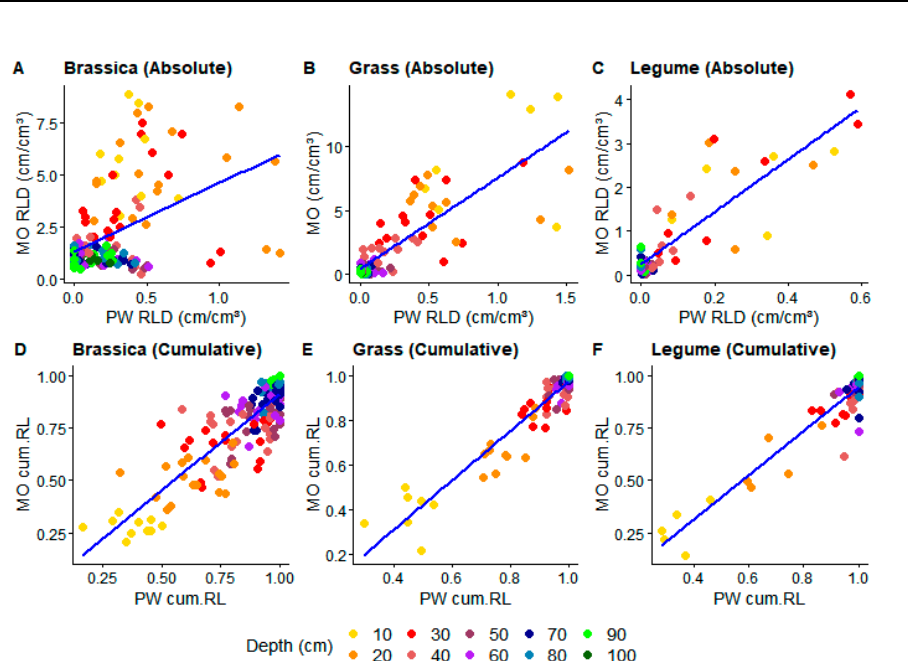
Figure 1. Linear regression fitting between monolith and profile wall root ‐ length density (RLD) in training data for absolute ( A – C ) and cumulative (cum.RL) data ( D – F ). Colors show soil depth (cm) of each value.